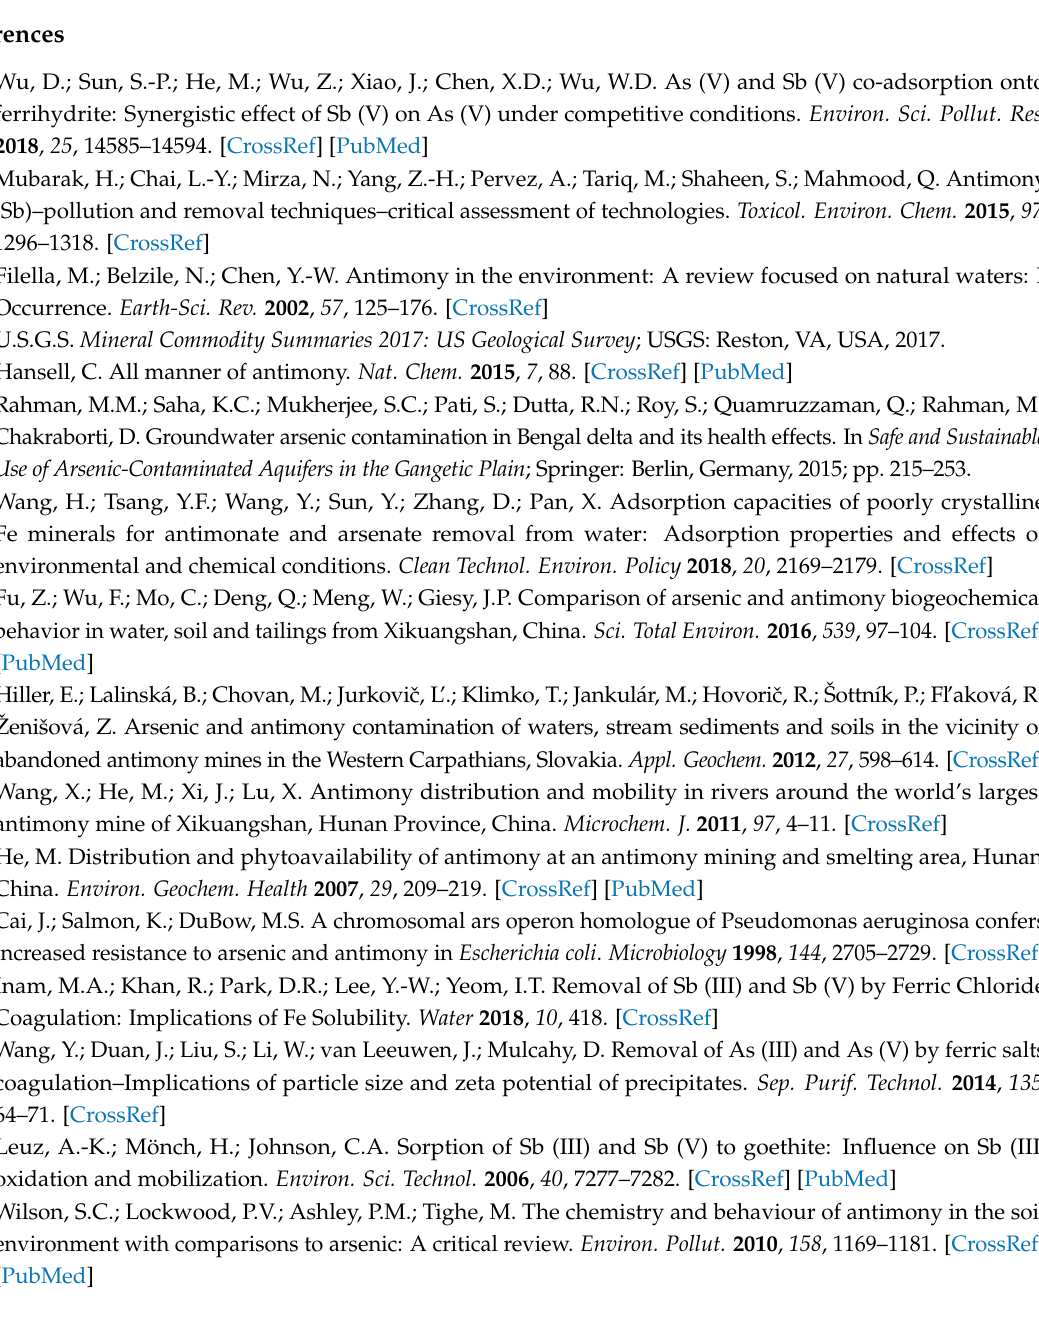
system showing change in pH after FC coagulation in the presence of As and Sb species in multicomponent environment. Figure S1: Speciation of Fe(III) species derived from Visual MINTEQ. Figure S2: Single solute system of As and Sb showing Fe solubility behavior at pH 7, 0.1 mM FC dose and varying initial concentration of (0–10) mg/L. Figure S3: Binary system of As and Sb showing Fe solubility behavior at pH 7, 0.1 mM FC dose and varying initial As-Sb concentration of (0–10) mg/L of each species, respectively. Figure S4: Quaternary system of As and Sb showing Fe solubility behavior at pH 7, 0.1 mM FC dose and varying initial As-Sb concentration of (0–10) mg/L of each species, respectively. Figure S5: FT-IR Spectra of pristine (A) FC, (B) and (C) Sb(III,V) and (B) and (C) As(III,V)